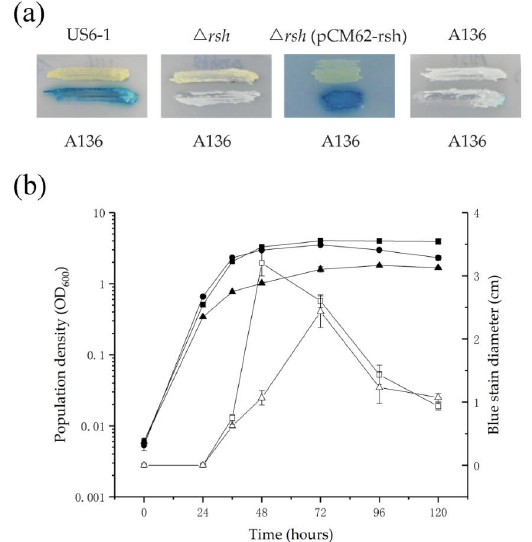
Figure 2. AHL accumulation in US6-1, ∆ rsh and ∆ rsh (pCM62-rsh). ( a ) AHL accumulation assay by cross-feeding. P5Y3 agar plate was covered with 50 µ L X-gal. The AHL reporter strain A136 and the tested strains were streaked side by side on the agar plates. Plates were incubated for 24 h, when the activation of the reporter was recorded. Strain A136 versus A136 was used as negative control. One representative experiment out of three independent biological replicates is shown. ( b ) Time course of population density of US6-1 (filled squares), ∆ rsh (filled circles) and ∆ rsh (pCM62-rsh) (filled triangles) and AHL accumulation of US6-1 (open squares) and ∆ rsh (pCM62-rsh) (open triangles) in the extract assay. Fresh colonies of strains were first inoculated into P5Y3 broth at the shaking speed of 200 rpm to an OD 600 value of 1. Then 250 µ L of this seed culture was re-inoculated into 50 mL of fresh P5Y3 broth and incubated statically. The growth curve was drawn from measuring the OD 600 values. AHL signals in cultures were then extracted by ethyl acetate (EA). The extracts were spotted onto LB soft agar plates plus X-gal mixed with A136. The plates were incubated for 12 h at 30 ◦ C and the diameters of blue stains which represented the quantity of AHL signals in bacterial cultures were measured. No AHL was detected in ∆ rsh . Values shown are the average of biological triplicate experiments with standard deviations marked with error